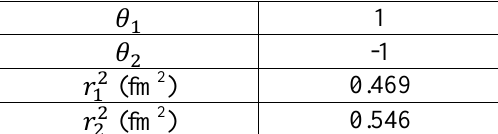
Table 1: Parameters of the neutron charge